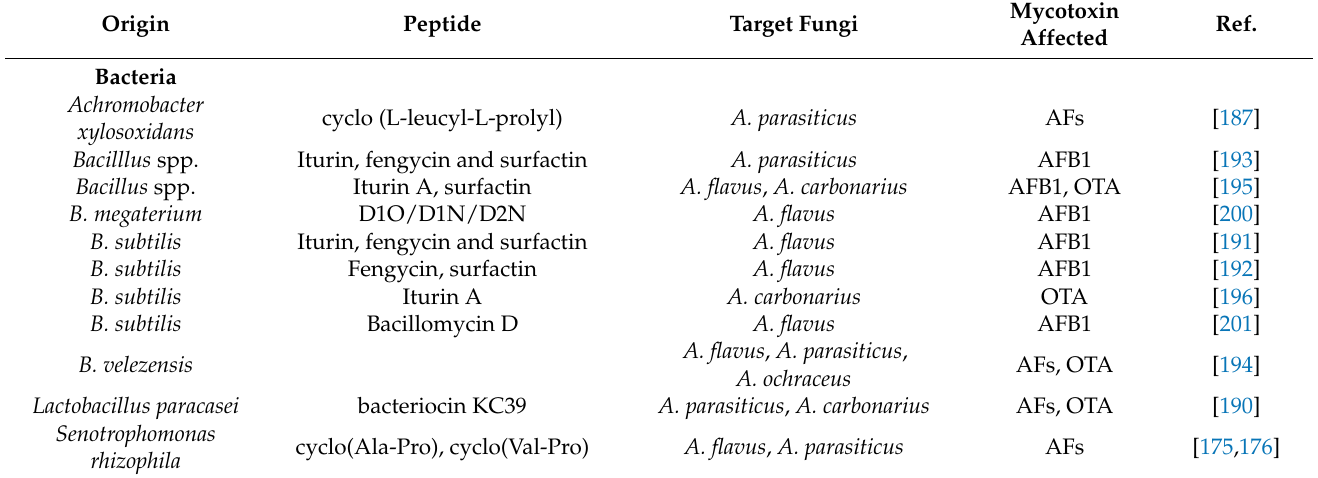
Table 5. Fungal AMPs that exert a reduction or inhibitory effect on mycotoxin